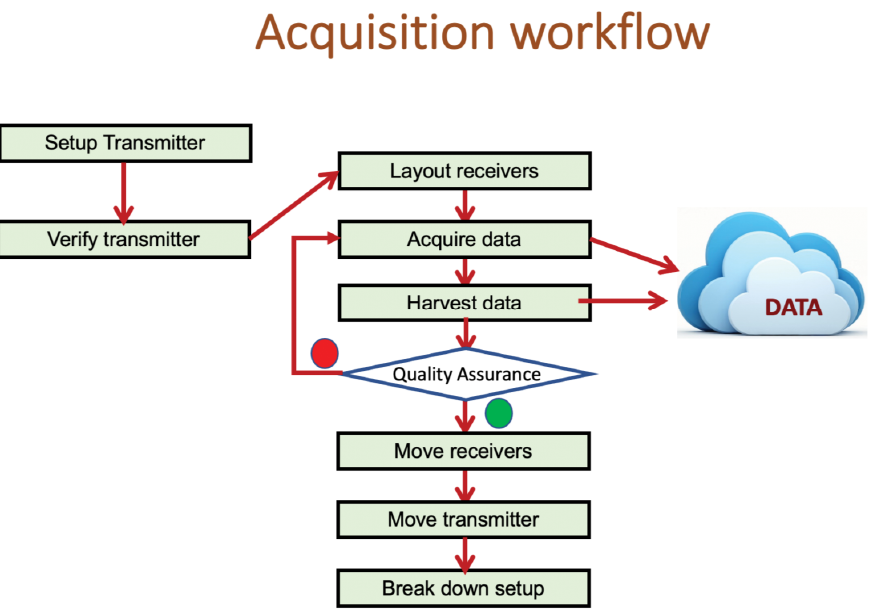
Figure 6. Acquisition workflow of a typical CSEM reservoir monitoring project. Quality assurance decisions are marked with red (NO GO) and green (GO) dots. The data are sent directly from the instrument to the Cloud.